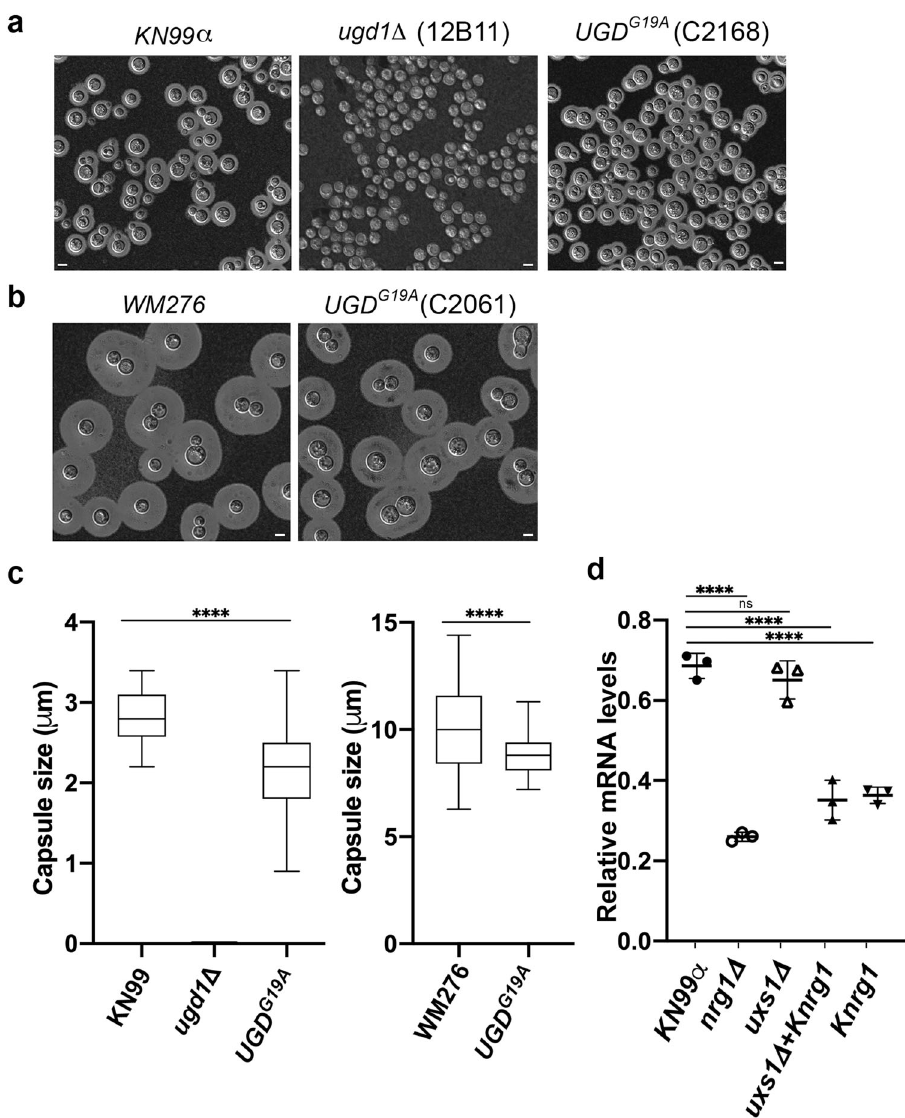
Fig. 6 The Ugd1 function or the UGD1 expression levels is affected in suppressor containing strains. a – c Capsule size is affected by the UGD1 G19A mutation. Cells were stained by India ink and visualized by microscopy. The experiments were repeated 4 times independently with similar results. The capsule sizes of more than 65 cells were measured from 5 different fi elds for each indicated strain. Capsular thickness was de fi ned as the distance between the visualized cell wall and the edge of the capsule. The box-and-whiskers plot is used to show median, quartiles (boxes), and range (whiskers). Two-tailed, unpaired t-test (**** p < 0.0001). Bar = 5 μ m. d UGD1 expression is downregulated in the Knrg1 containing strains. RNA was isolated and the expression levels of UGD1 were determined by qRT-PCR, normalized to the actin gene. The experiments were repeated three times. One-way ANOVA with Tukey ’